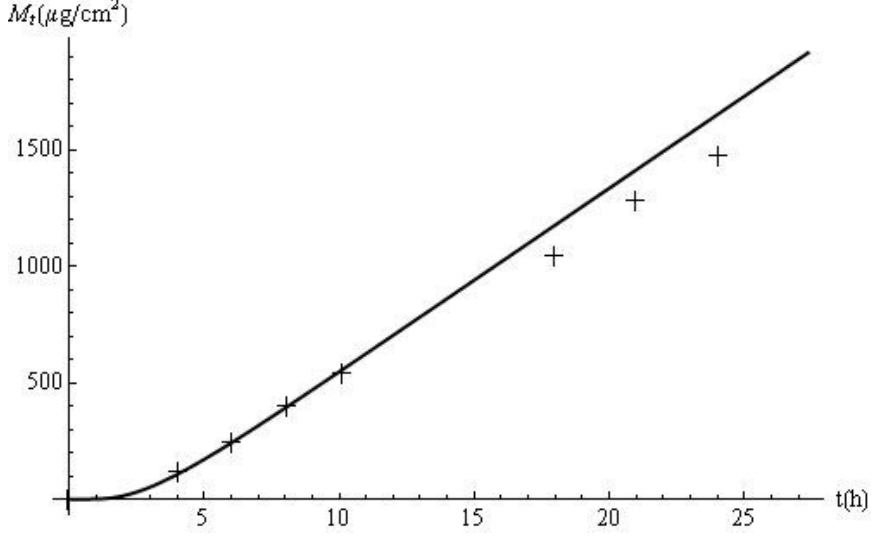
Figure 1. Cumulative amount of metoprolol released (experimental: +; predicted: